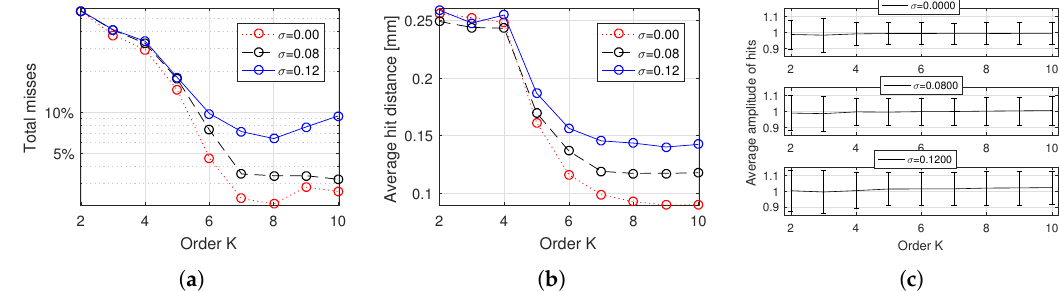
Figure 6. ( a ) percentage of misses (from 1000 simulated events) as a function of K, for three levels of noise, with OMPED running with a fixed number of five iterations (each of the 200 simulated acquisition had five scatterers). Each recovered scatterer distant more than 0.5 mm in any direction (axial or lateral) from the closest original simulated scatterer was computed as a miss. A minimum in the global number of misses is found at K = 8. For K > 8, a little amount of useful information is added to the dictionary at the expense of increased coherence; ( b ) distance between recovered events (hits) and their corresponding simulated true event; ( c ) average amplitude of the events computed as hits, for noise levels σ = 0 (up), σ = 0.08 (middle) and σ = 0.12 (bottom). The bars indicate one standard deviation above and below the average. All simulated events have unity